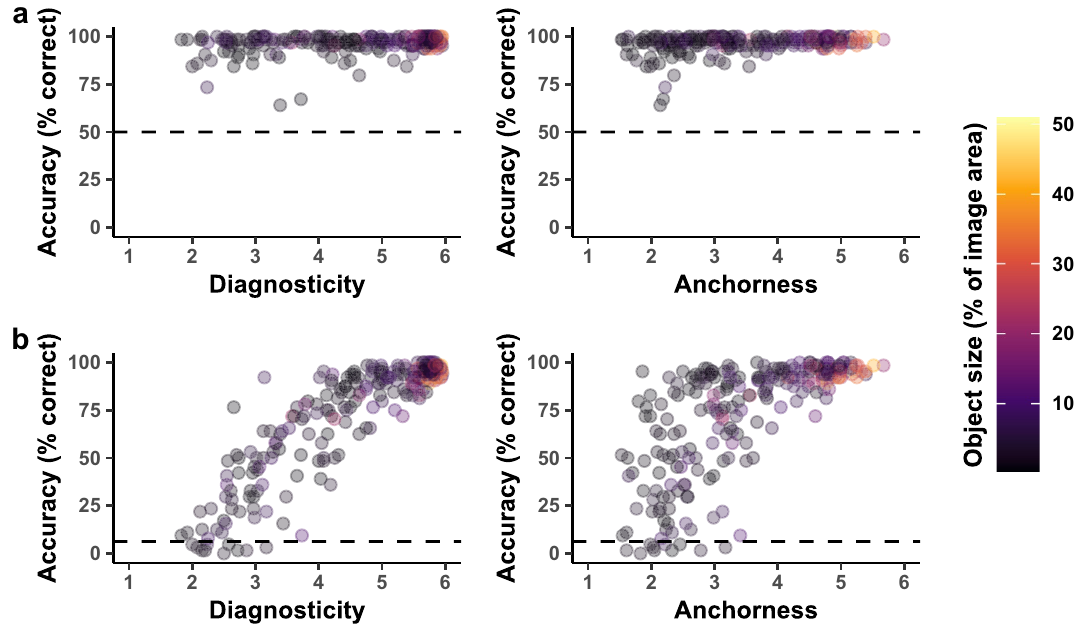
Figure 2. Observed ( a ) superordinate-level and ( b ) basic-level scene categorization accuracy in Experiment 1 as a function of diagnosticity, anchorness and object size on the screen. Points represent individual images averaged across participants. The dashed lines indicate the expected chance level in the superordinate-level (50%) and basic-level scene categorization task